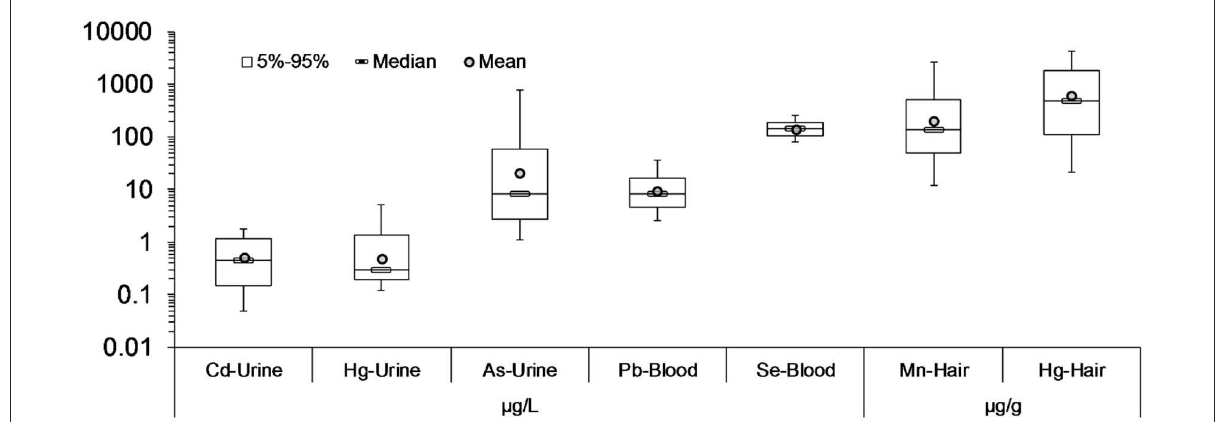
FIGURE8 Heavy metals concentration in blood, urine and hair from the children participated in HERACLES cohort. In urine, As was found in highest concentrations, while in hair the Hg. The lowest concentrations in urine belongs to Cd, and in hair in Se, which role is mostly beneficial for a child’s neurodevelopment.